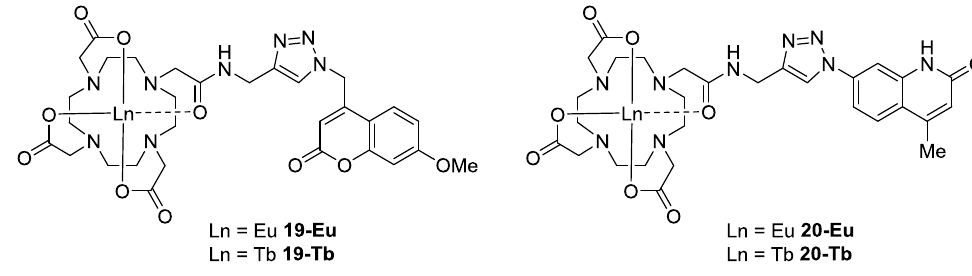
Figure 4. Structures of lead sensors 19-Eu / Tb and 20-Eu / Tb . Table 2. Normalized Values for Signal Increase for Sensors 19 and 20 .